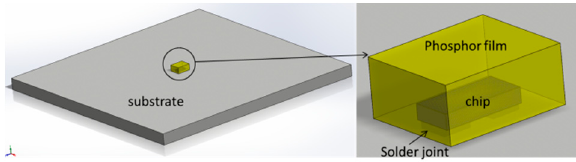
Figure 1. The structure of white chip scale package LEDs (LED CSP).